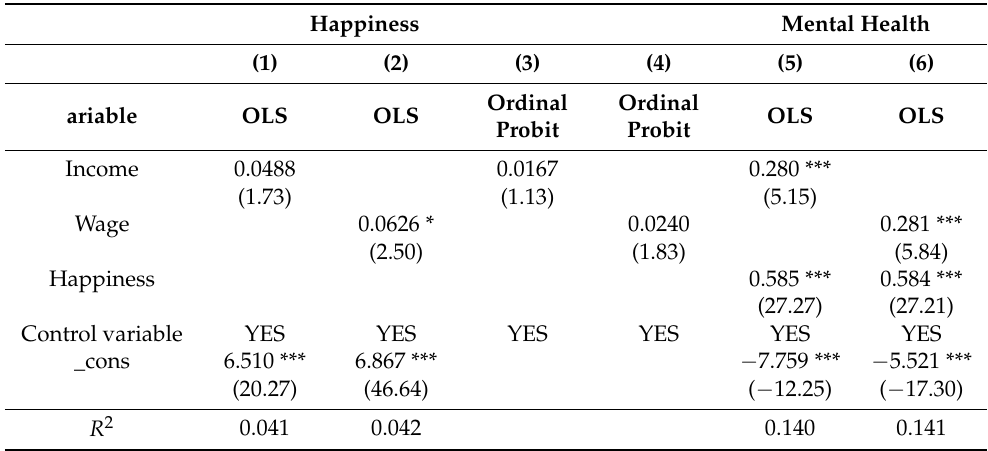
Table 9. With happiness as a mediating